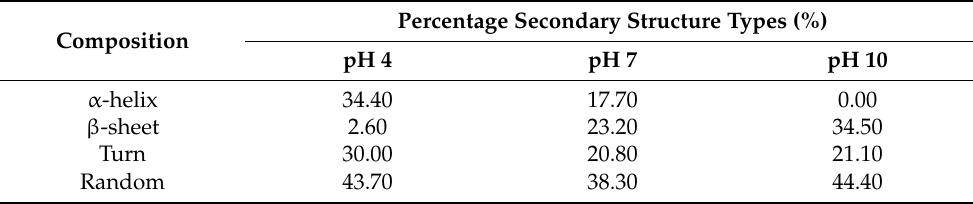
Table 2. Secondary structure composition of Palmitoyl-GDPH at 37 ◦ C.